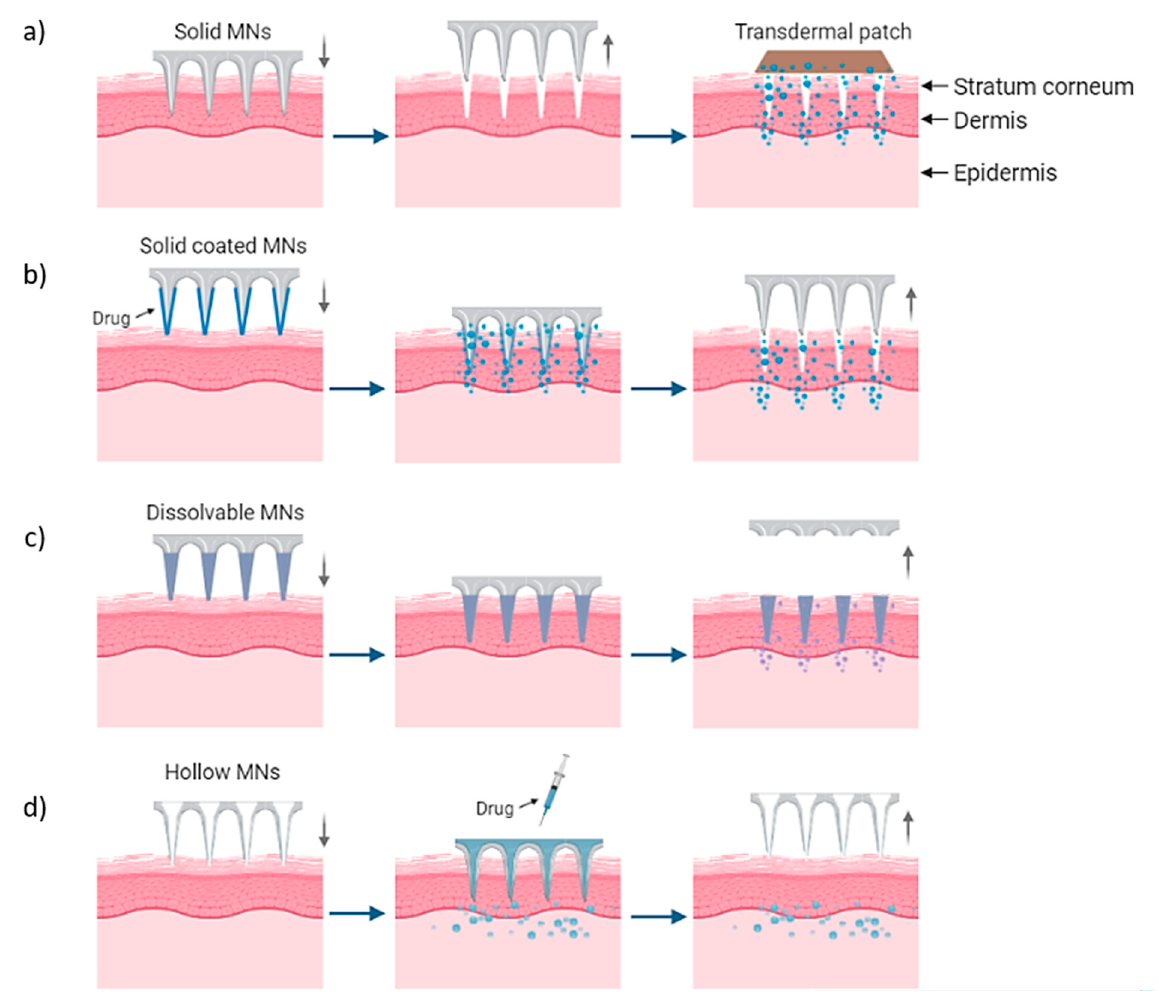
Figure 2. Delivery procedures of solid MNs through the ( a ) ‘poke − detach − diffuse’ method, in which the solid MNs are used only for the creation of holes and the drug administration is provided by a transdermal patch and ( b ) ‘coat and poke’ method where the drug is coated on the needles and the drug administration is provided from the MNs. ( c ) “Poke and flow” method in which the drug is inserted through hollow MNs and delivered in the body and ( d ) “poke and release” method for dissolvable MNs which are inserted and dissolved in the skin [14].